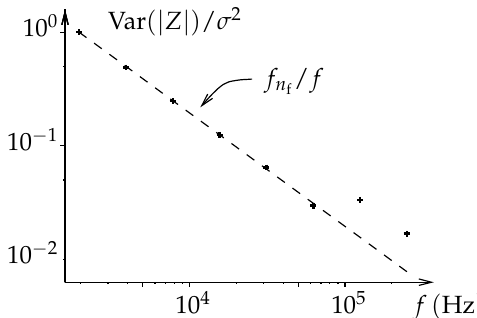
Figure 11. Variance of the impedance measurements exhibiting 1/ f evolution. The variance is numerically estimated over 1000 random trials where gaussian noise has been added to ADC datas. Variance is normalized by noise power ( σ 2